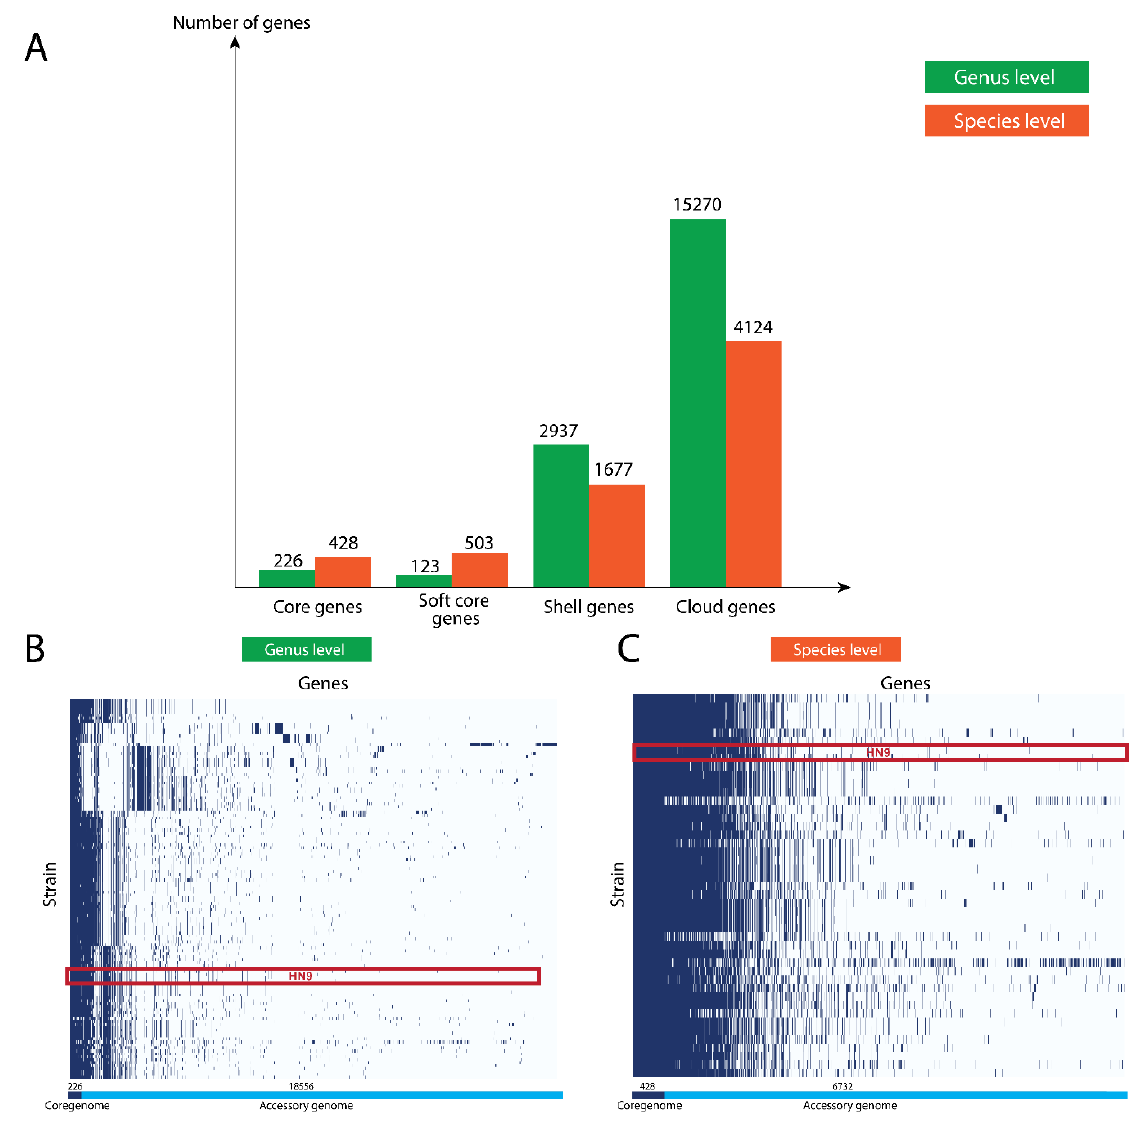
Figure 2. Pan-genome analyses of P. acidilactici HN9 at species and genus levels determined using Roary software. 45 and 129 strains were compared at the species and genus levels, respectively. ( A ) The summary of pan-genome analyses at both levels. ( B , C ) plots of pan-genome matrices-based genus and species levels, respectively. The presence of each gene in each strain is indicated by the blue color, while the white color indicates the absence of the gene from the strain. The red box represents a set of genes of P. acidilactici HN9.